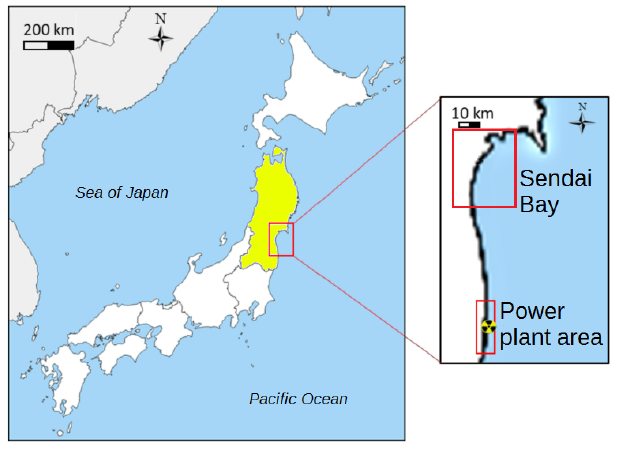
Figure 1. Zoom-in on the Tohoku region (in yellow), and the main study areas seen in the